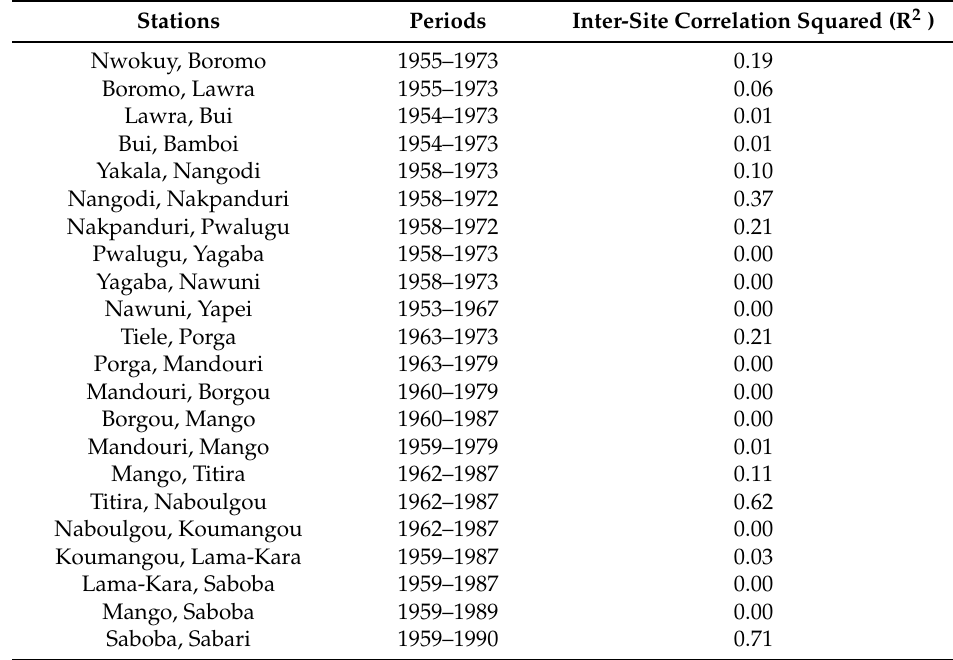
Table 2. Inter-site correlation of annual maximum discharges (AMAX) in the Volta River Basin. Stations Periods